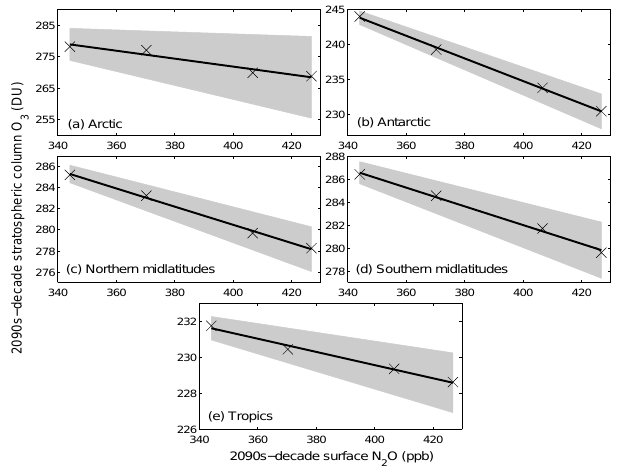
Fig. 7. (a) 2090s-mean Arctic (63–90 ◦ N) stratospheric column ozone (1–100hPa) vs. 2090s-mean surface N 2 O for the four N 2 O simulations (crosses), fitted with a simple linear regression model (black line). The grey shaded region indicates the 95% confidence interval for the slope and intercept of the regression model. (b– e) As for (a) , but for: (b) the Antarctic (63–90 ◦ S); (c) northern mid- latitudes (30–60 ◦ N); (d) southern midlatitudes (30–60 ◦ S); (e) the tropics (25 ◦ N–25 ◦ S).